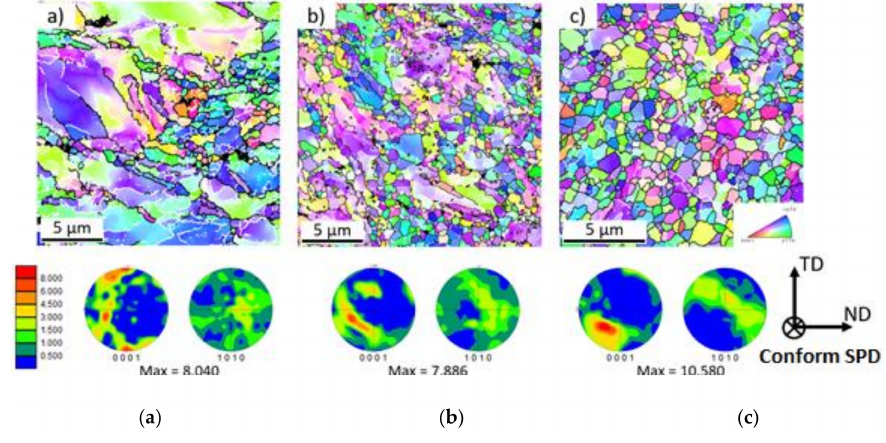
Figure 6. Cross-section orientation image maps (OIM) and inverse pole figure (IPF) maps for samples after ( a ) first pass (50 × 50 µ m), ( b ) second pass (20 × 20 µ m), and ( c ) third pass (15 × 15 µ m) through Conform SPD. In the figure on the left, the scale of texture intensities is shown as multiples of the random density (m.r.d.) from 0–8.000. The maximum value of each texture is listed below the IPF maps. The orientation triangle for the electron-backscatter diffraction (EBSD) maps is shown in the right-hand corner of the figure.